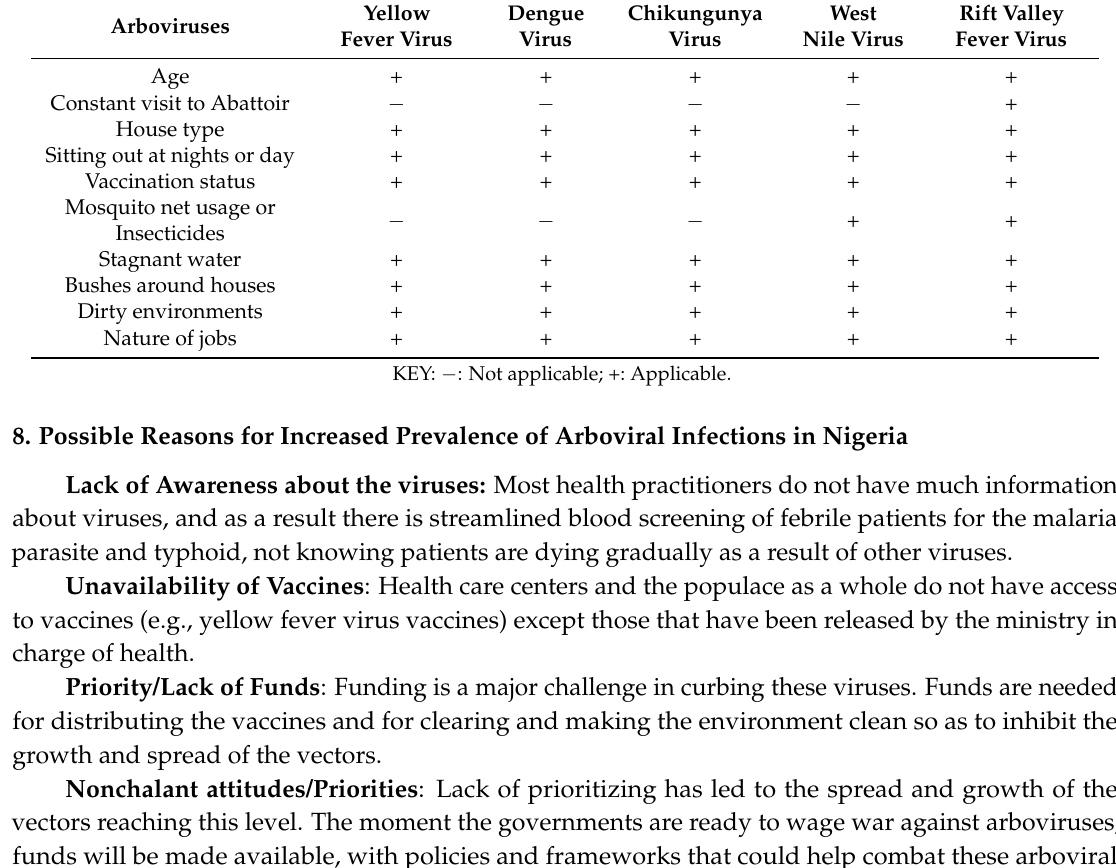
Dengue Chikungunya West Rift Valley Virus Virus Nile Virus Fever